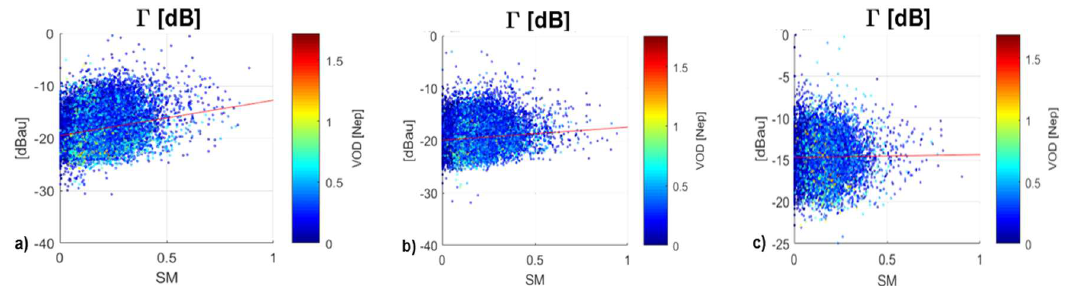
Figure 12. Calibrated TDS-1 GNSS-R reflectivity Г [dB] but not corrected for vegetation and surface roughness effects vs. SMOS SM data for different ranges of incidence angle: ( a ) from 0° to 30°; ( b ) from 30° to 60°; and ( c ) from 60° to 90°.